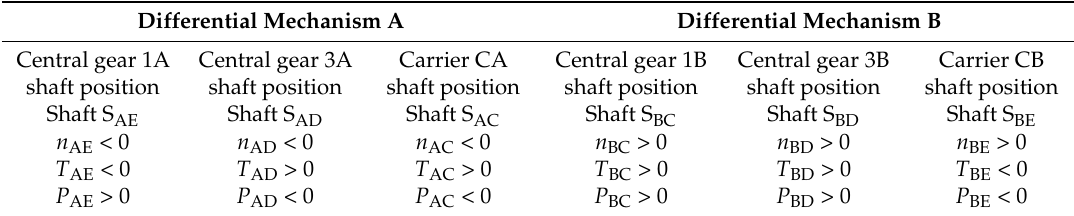
Table 1. Distribution of the speed, torque and power signs of the DMs A and